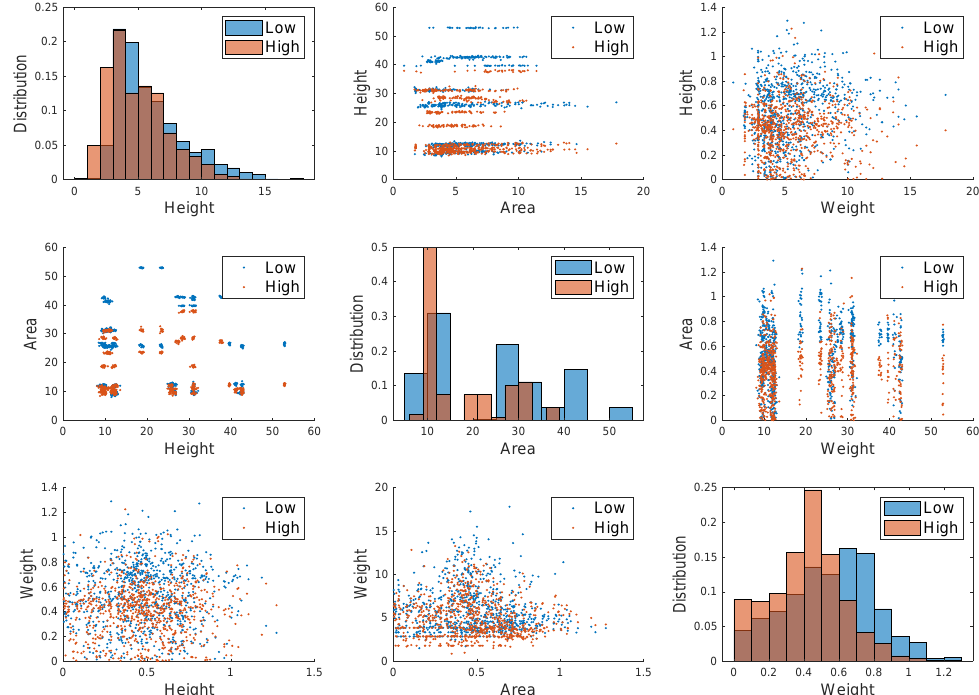
Figure 13. Features plants height , leaf area and leaf weight data as a pairwise scatter plot. The diagonal plots the marginal histograms of the three features. The off diagonals contain scatterplots of all possible pairs of features. As indicated in the legend, brown points are related to feature of plants gathered in low density racks, while the azure points are related to features of plants gathered in high density